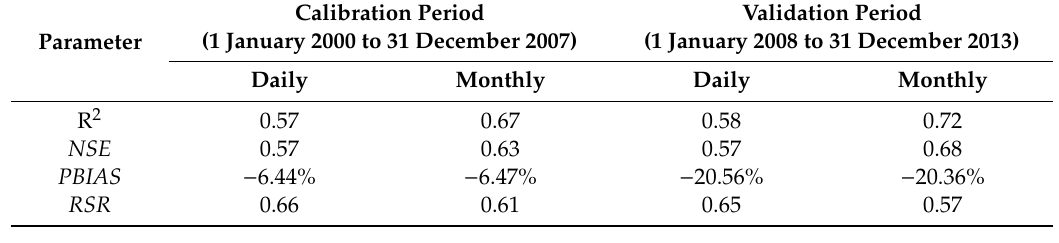
Table 4. Runo ff calibration and validation results for Sugar Creek watershed.